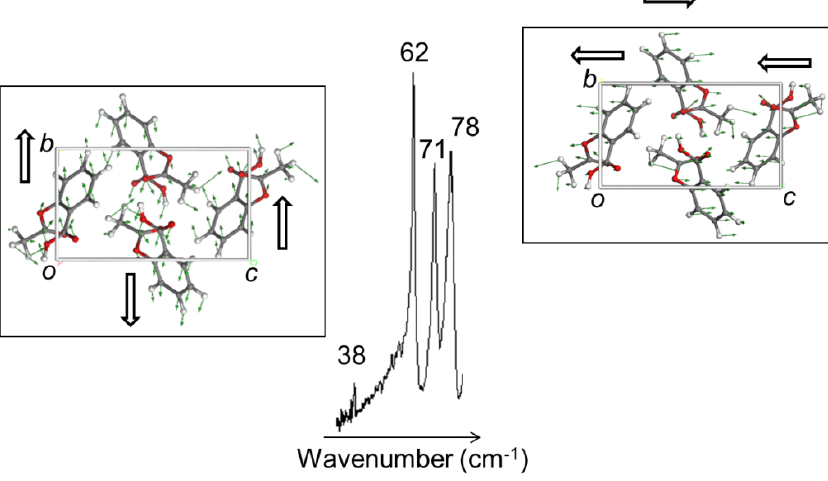
Figure 6. The THz spectrum of aspirin at 4 K, and the displacement vector of two modes assigned to translational vibrations [72]. The arrows indicate the displacement of chains nearly along the b -axis ( left ) and the c -axis ( right